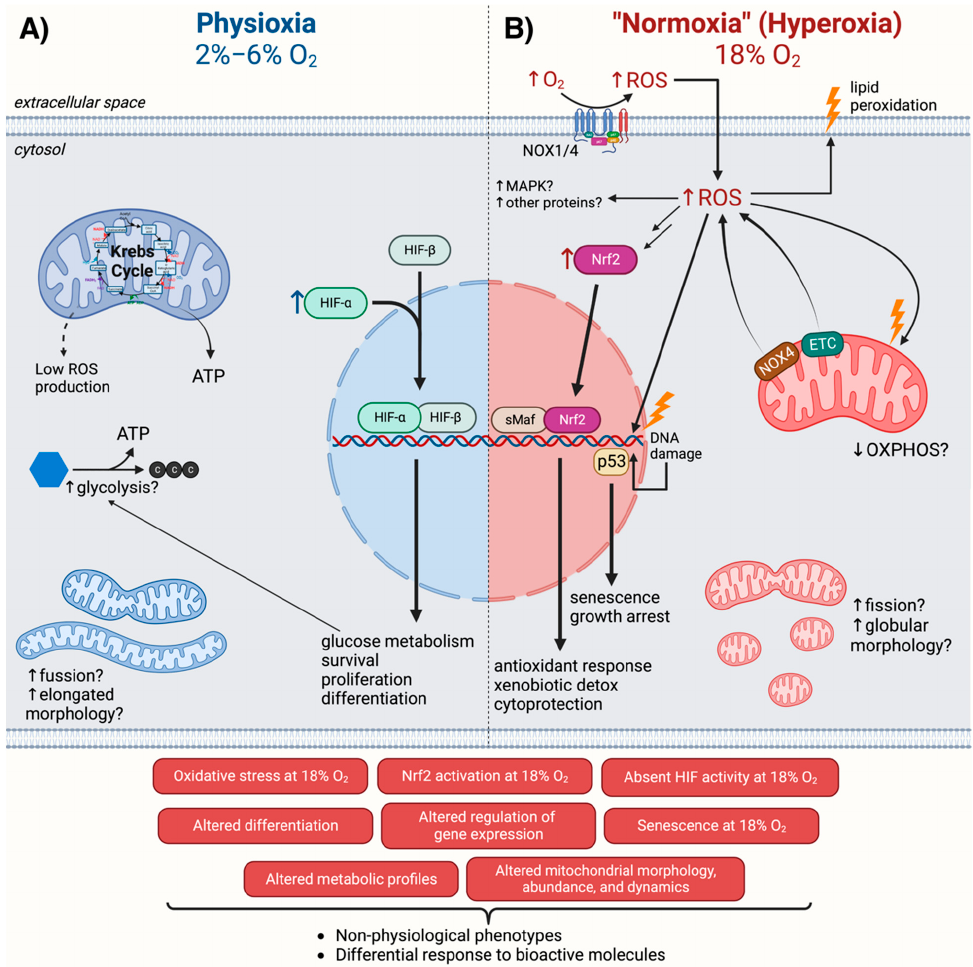
Figure 2. Cellular mechanisms differentially regulated at physioxia (2–6% O 2 ) versus normoxia (18% O 2 ). In physioxia ( A ), activation of HIF may drive the induction of genes that regulate glucose